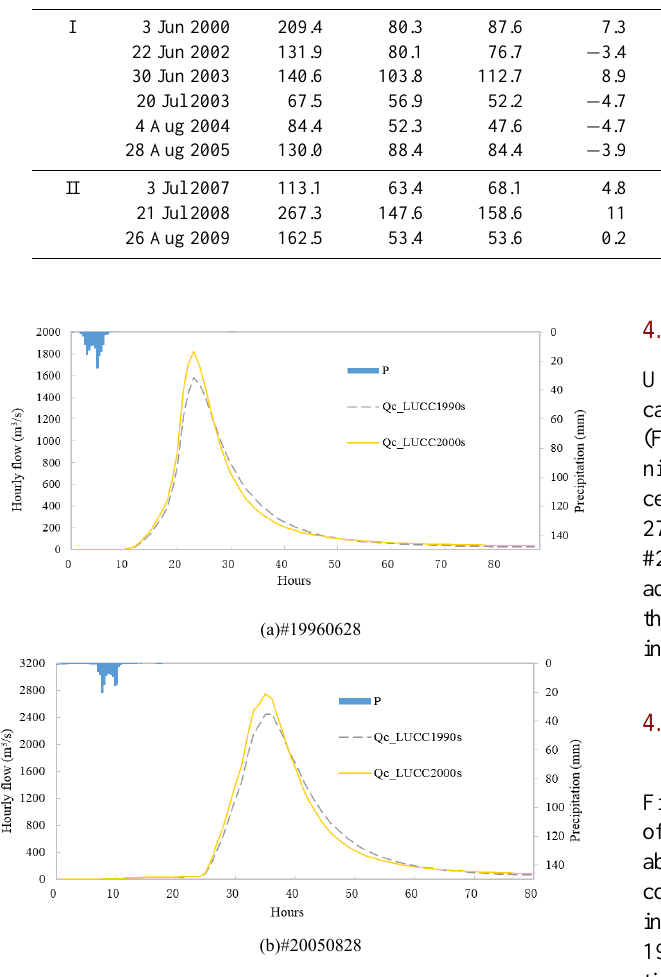
Figure 3. Temporal variations of hourly flow for different flood